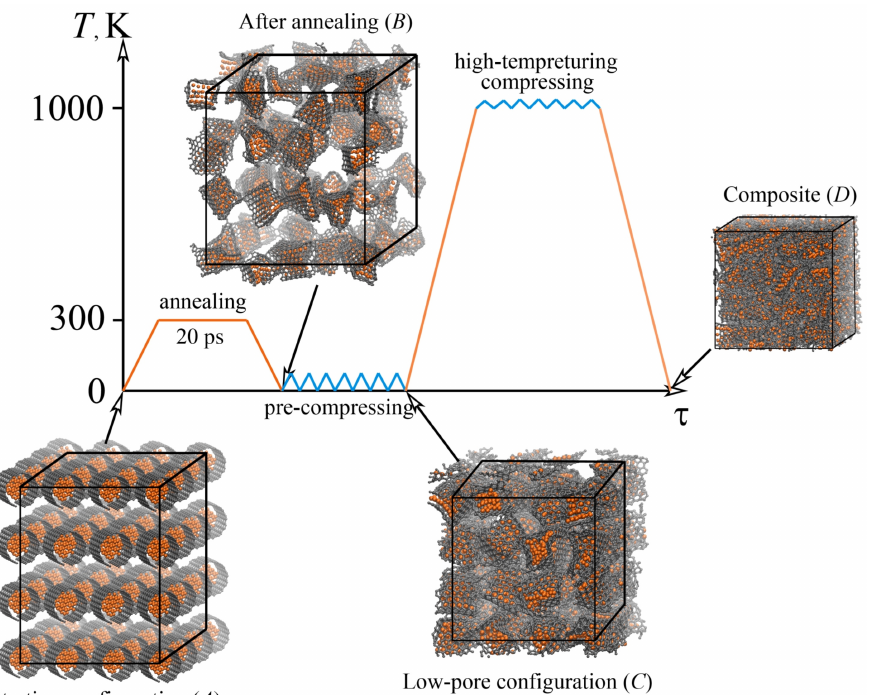
Figure 5. Scheme of the performed tests and their corresponding conditions to obtain a Ni/graphene composite. Snapshots of the structures in the initial (A), final (D) states, and states after each processing stage (stage B, after annealing at 300 K for 20 ps; stage C, after pre-compression). Nickel atoms are shown in orange and Carbon atoms—in gray color. Reprinted with permission from